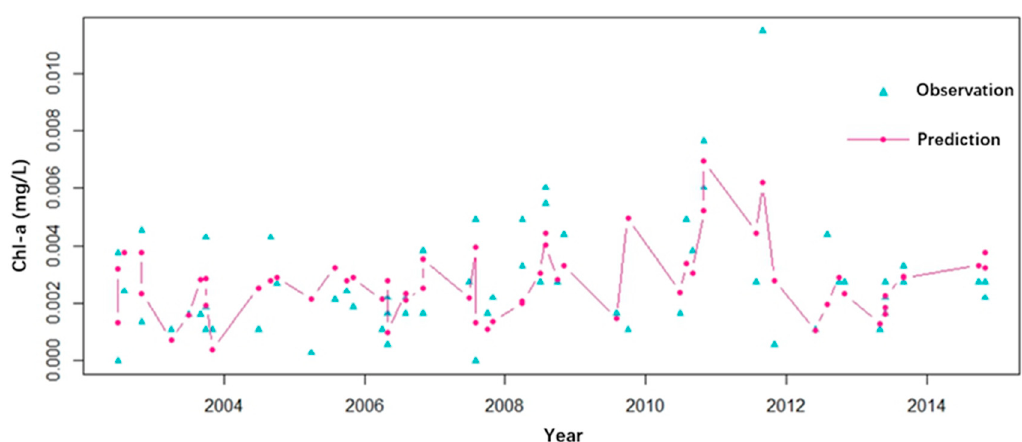
Figure 7. Prediction results of SVM model in test stage.